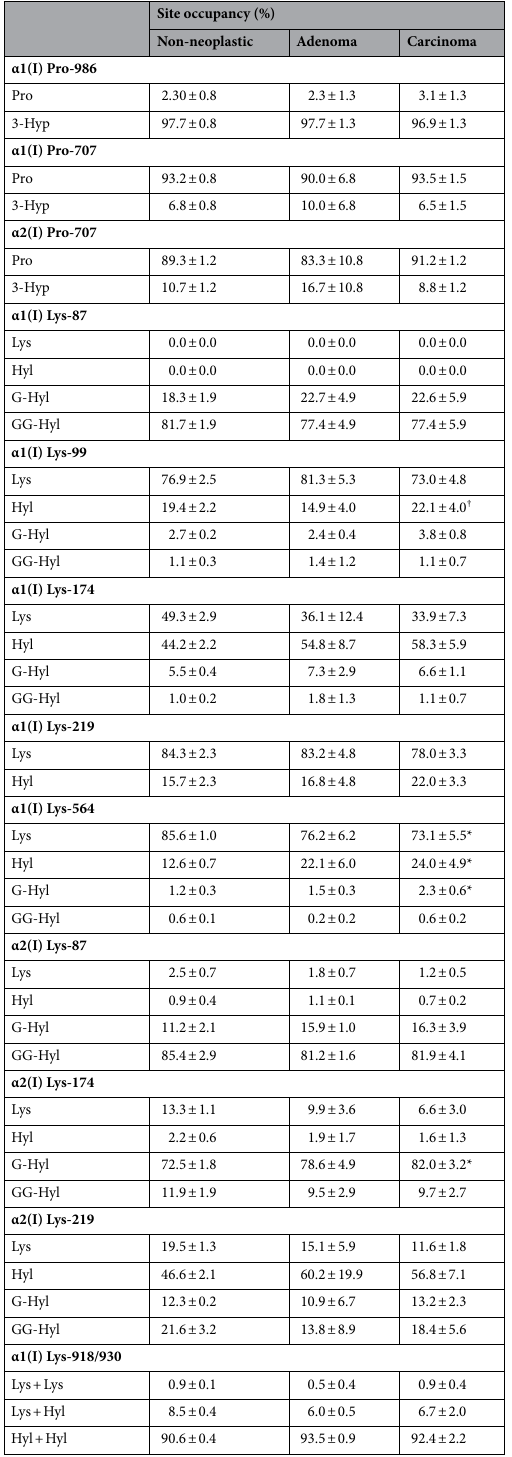
Table 3. Summary of site-specific modification analysis by mass spectrometry of non-cross-linked, hydroxylated and glycosylated residues in the triple helical domain of type I collagen from canine mammary tissues. Lys hydroxylation and its glycosylation (%) represents the relative levels of Lys, Hyl, G-Hyl, and GG-Hyl (Lys + Hyl + G-Hyl + GG-Hyl = 100%), and Pro 3-hydroxylation represents the relative levels of Pro and 3-Hyp (Pro + 3-Hyp = 100%). Pro, proline; 3-Hyp, 3-hydroxyproline; Lys, lysine; Hyl, hydroxylysine; G-, galactosyl-; GG-, glucosylgalactosyl. Values represent mean percentages ± SD (non-neoplastic, n = 3; adenoma, n = 3; carcinoma, n = 6). * p < 0.05 between non-neoplastic and adenoma or carcinoma. † p < 0.05 between adenoma and carcinoma via Kruskal–Wallis followed by a Dunn’s multiple comparisons